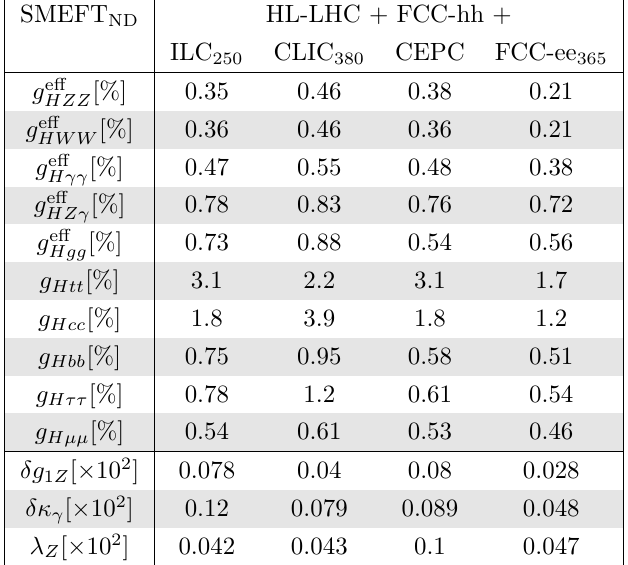
(cid:0) colliders